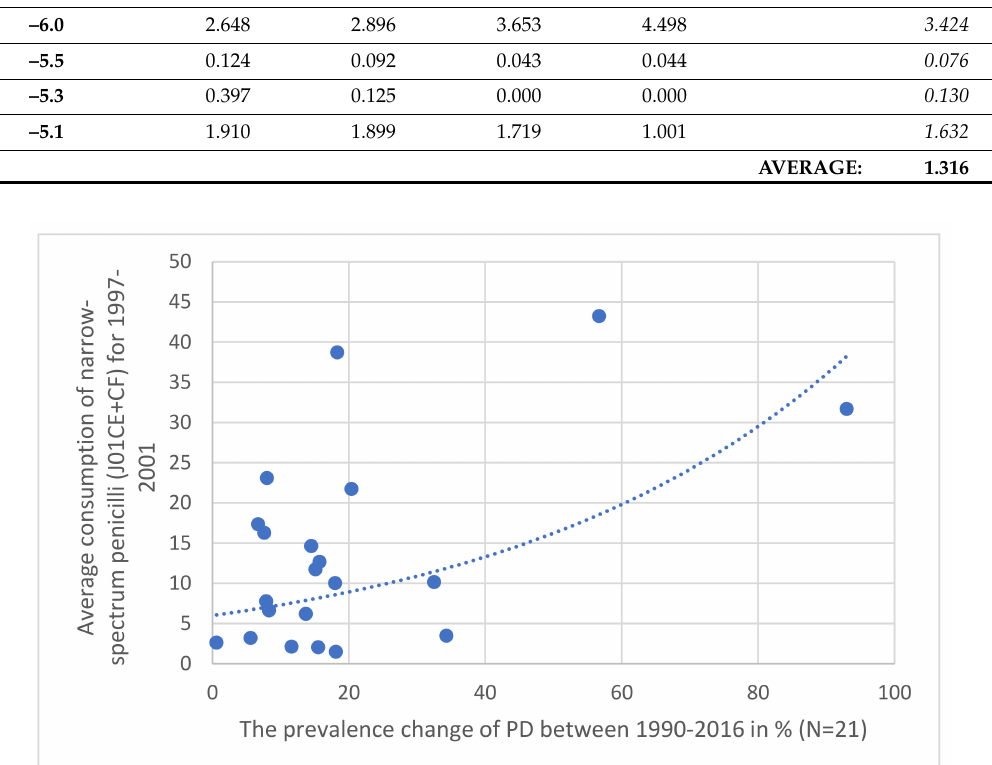
Figure 1. Correlation observed between the prevalence increase of PD in 21 European countries (1997–2001) compared to the relative share of the consumption of narrow-spectrum, beta-lactamase sensitive (J01CE) and resistant (J01CF) penicillin (J01CE +